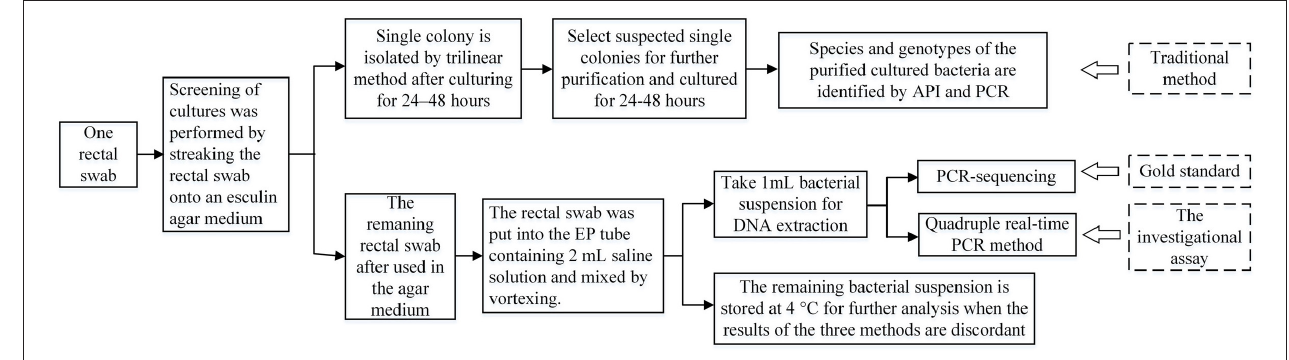
FIGURE 1 | The procedure of the three methods in this